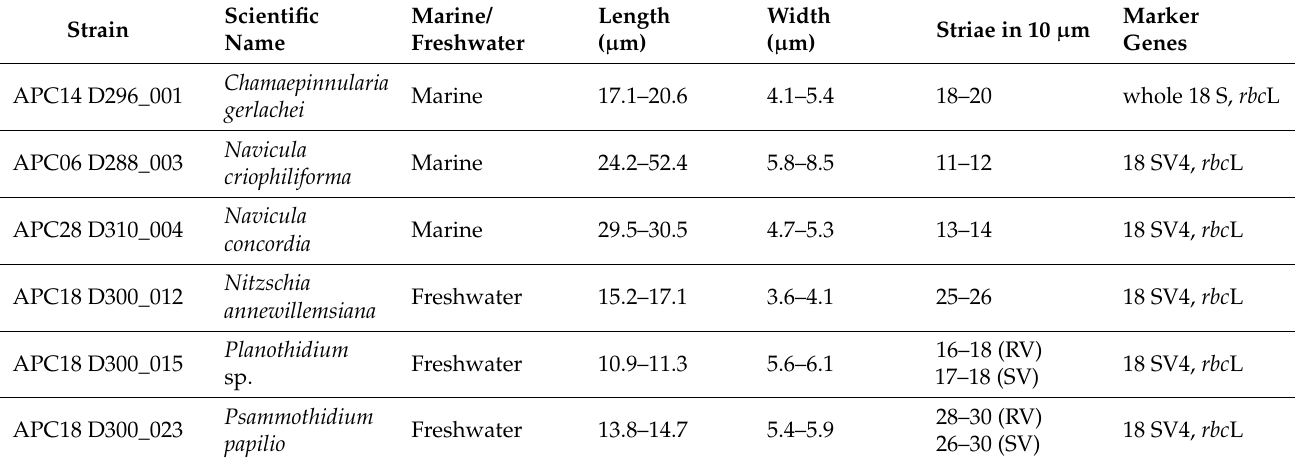
Table 2. List of strains established from Antarctic marine and freshwater samples collected at Carlini Station, King George Island, Potter Cove, in austral summer 2020 (January/February), with scientific name, information on dimensions of the valves, striae density, and sequenced marker genes. RV: raphe valve, SV: sternum